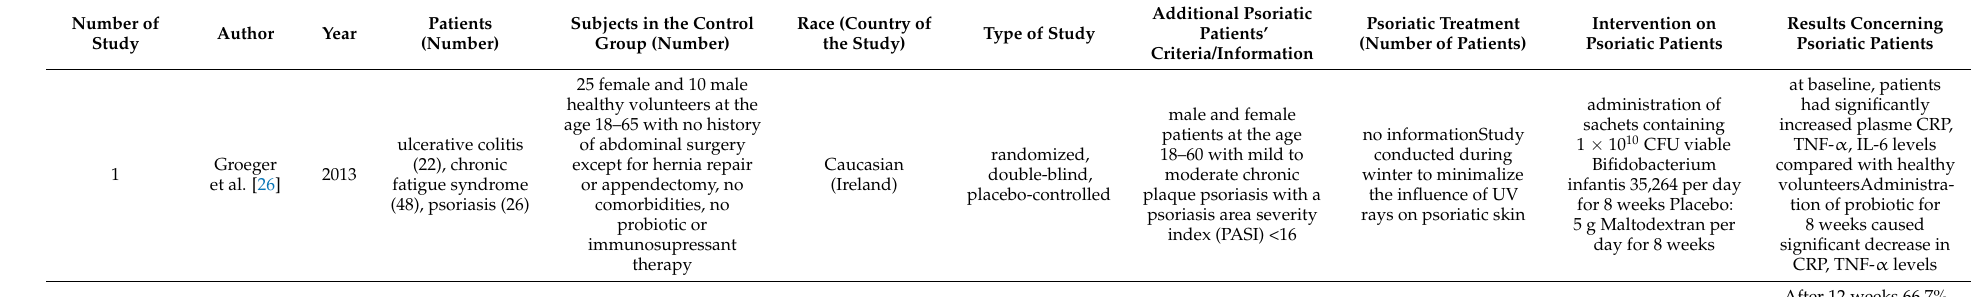
Table 2. Research on probiotics oral administration in